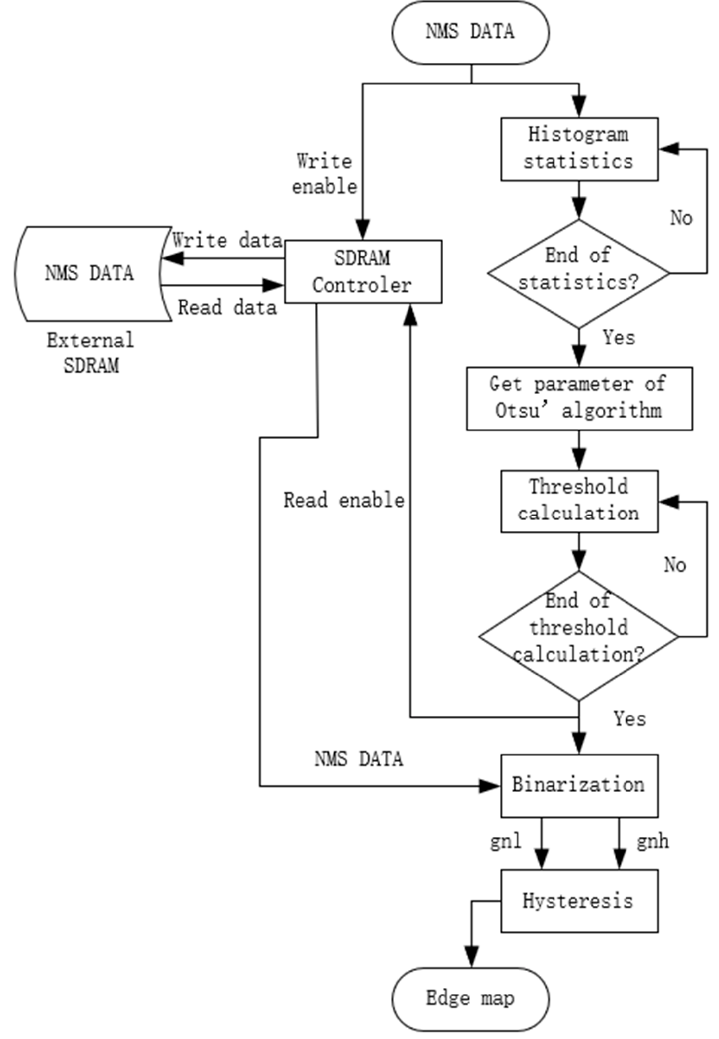
Figure 10. Flow diagram of the system after NMS.